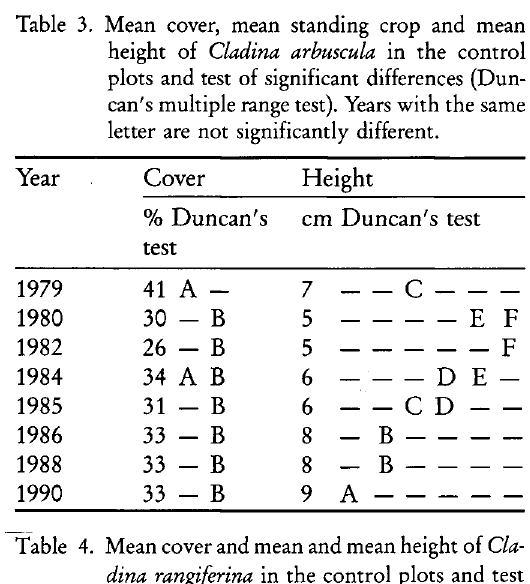
Table 4. Mean cover and mean and mean height of Cla dina rangiferina in the control plots and test of significant differences (Duncan's multiple range test). Years with the same letter are not significantly different.